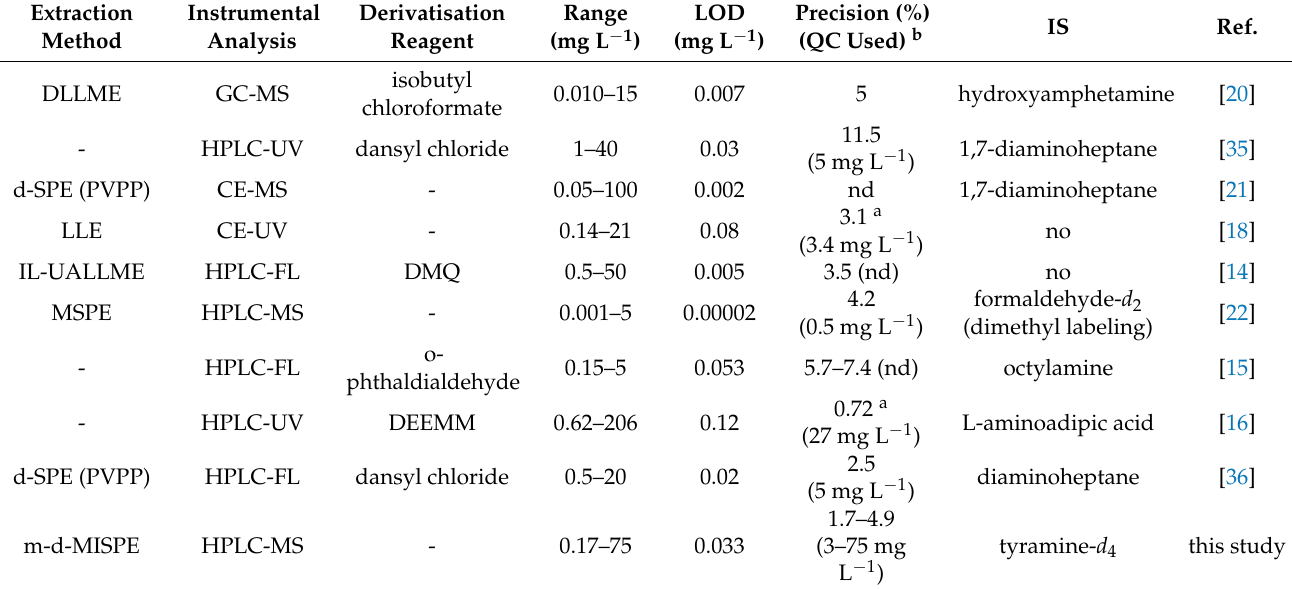
Table 1. Tyramine analyses in samples of beer by LC, GC, and CE using different extraction techniques and instrumental analyses.